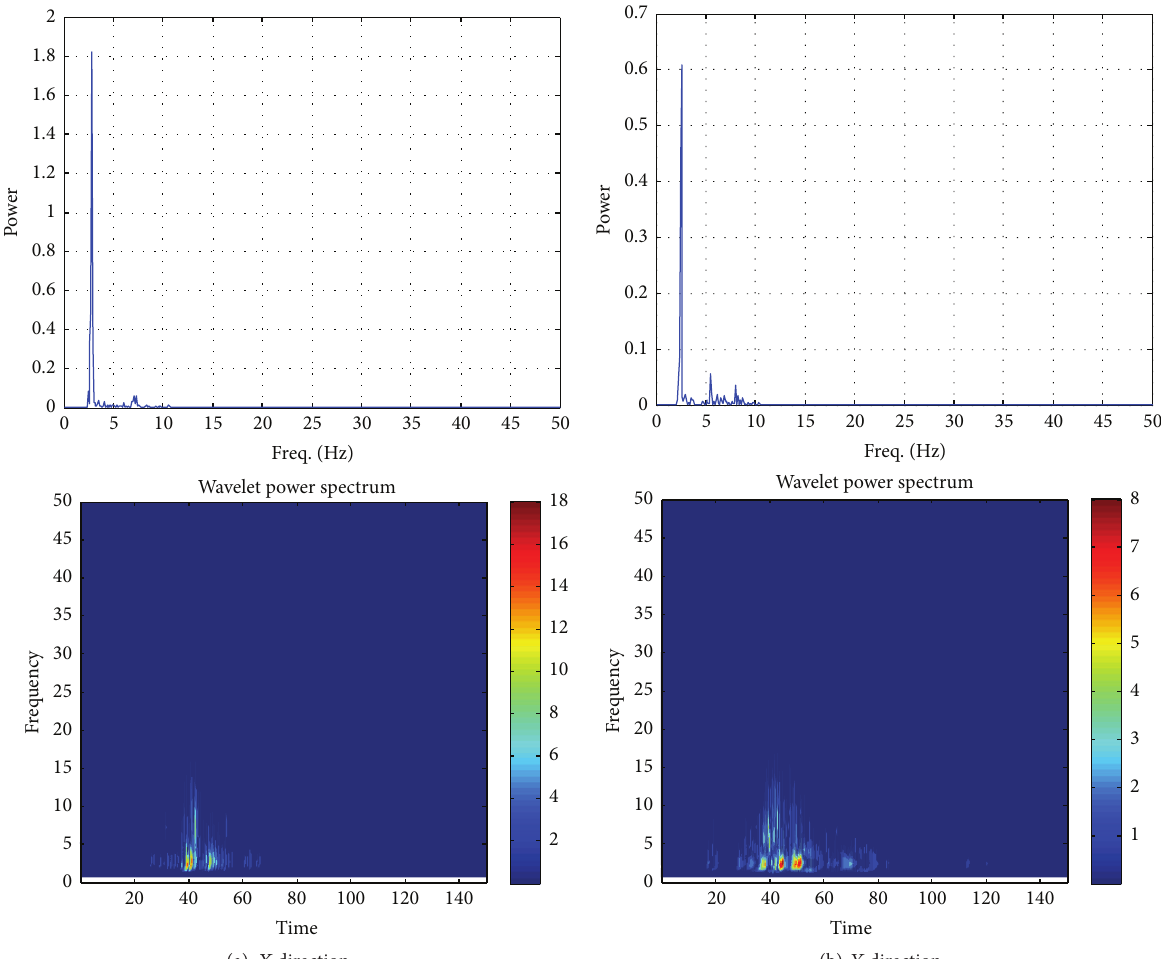
Figure 16: Frequency models and wavelet spectrum of roof point for 𝑋 and 𝑌